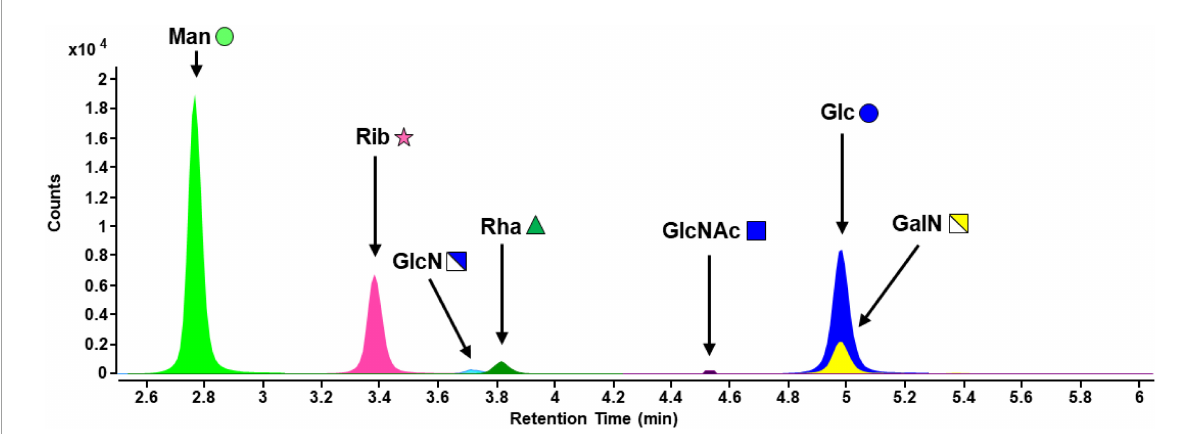
FIGURE3 MRM chromatogram of carbohydrates of hydrolyzed EPS from S acidocaldarius MW001 biofilms cultivated on hydrophilic PTFE membranes at 76 ◦ C for 4 days (liquid Brock medium, pH 3.0, 0.1% ( w/v ) NZA, 0.2% ( w/v ) glucose, 10 µ g/mL uracil). Monosaccharide symbols were used according to the glycan nomenclature of NCBI (Man, mannose; Rib, ribose; GlcN, glucosamine; Rha, rhamnose; GlcNAc, N -acetylglucosamine; Glc, glucose; GalN, galactosamine). Further information on the analytical performance of the RP-LC-MS method can be found in Supplementary Table 3